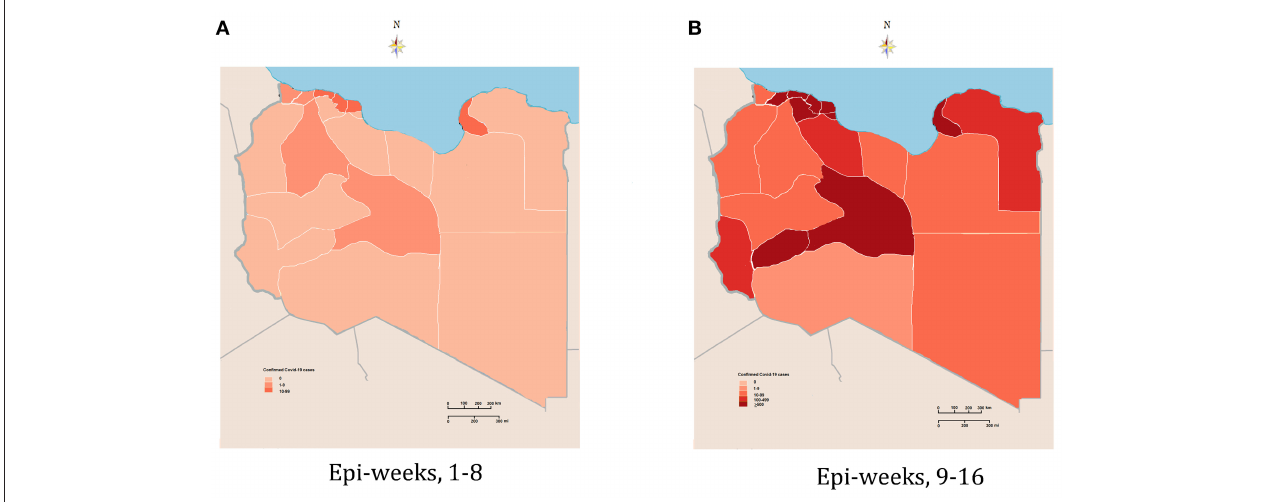
FIGURE 5 | Geographic and spatiotemporal distribution of the confirmed cases of COVID-19 in Libya. (A) Early stage of the epidemic (epi-weeks 1–8). (B) Second stage of the epidemic (epi-weeks